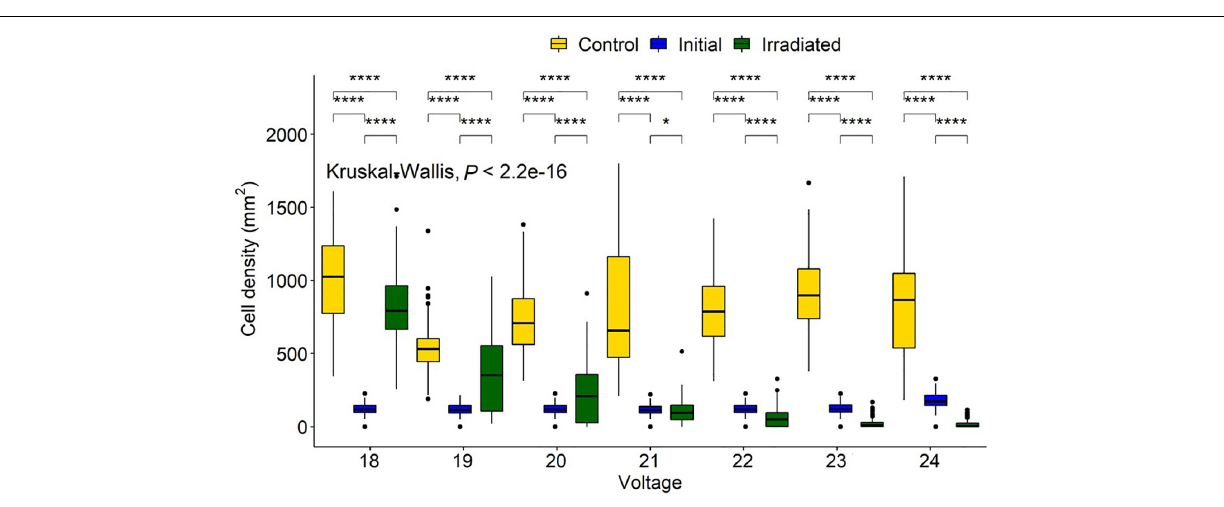
FIGURE 8 | Navicula incerta abundance and range after UV irradiance over varying voltages. Kruskal-Wallis value displayed with Wilcoxon pairwise comparison ranged above groupings (* P < 0.05, **** P <